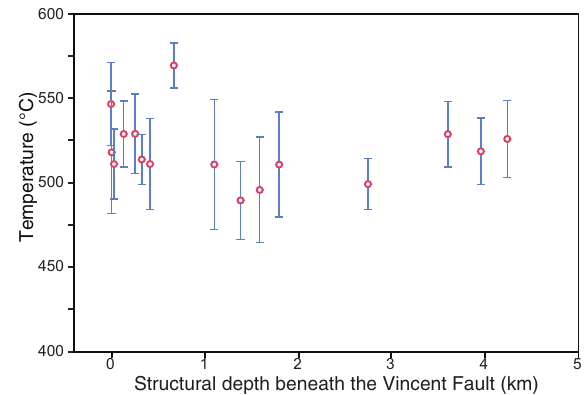
Figure 9. Peak temperature of Pelona Schist constrained by laser Raman spectroscopy. See Tables S1 and S2 for sample locations and detailed